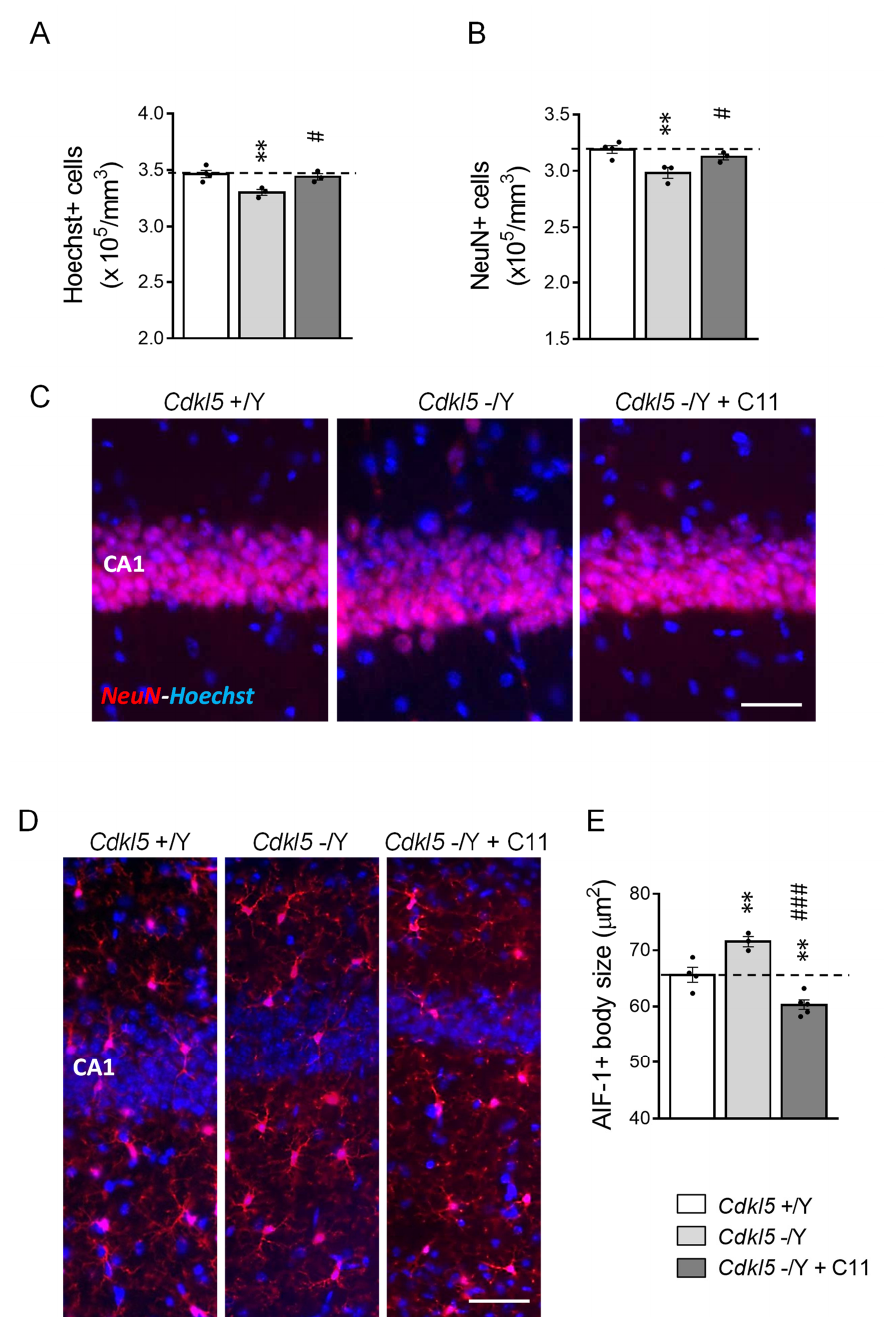
Figure 7. Effect of treatment with C11 on neuronal survival and microglia activation in the hippocampus of Cdkl5 − /Y mice. ( A , B ) Quantification of Hoechst-positive cells ( A ) and NeuN-positive cells ( B ) in CA1 layer of hippocampal sections from intraperitoneal vehicle-treated ( Cdkl5 +/Y; n = 4, Cdkl5 − /Y; n = 5; P60) and C11 -treated ( Cdkl5 − /Y + C11 ; n = 4; P60) mice. ( C ) Representative fluorescence images of immunopositive for NeuN (red) and counterstained with Hoechst (blue) sections in the hippocampal CA1 region of one animal from each group. Scale bar = 50 µ m. ( D ) Representative fluorescence images of hippocampal sections processed for AIF-1 immunohistochemistry of one animal from each group. ( E ) Mean microglia cell body size in hippocampal sections from vehicle-treated ( Cdkl5 +/Y; n = 4, Cdkl5 − /Y; n = 5; P60) and C11 -treated ( Cdkl5 − /Y + C11 ; n = 4; P60) mice. Scale bar = 50 µ m. Values are represented as means ± SE. ** p < 0.01, as compared to the vehicle-treated Cdkl5 +/Y mice; # p < 0.05; ### p < 0.001 as compared to the vehicle-treated Cdkl5 − /Y mice (Fisher’s LSD test after one-way